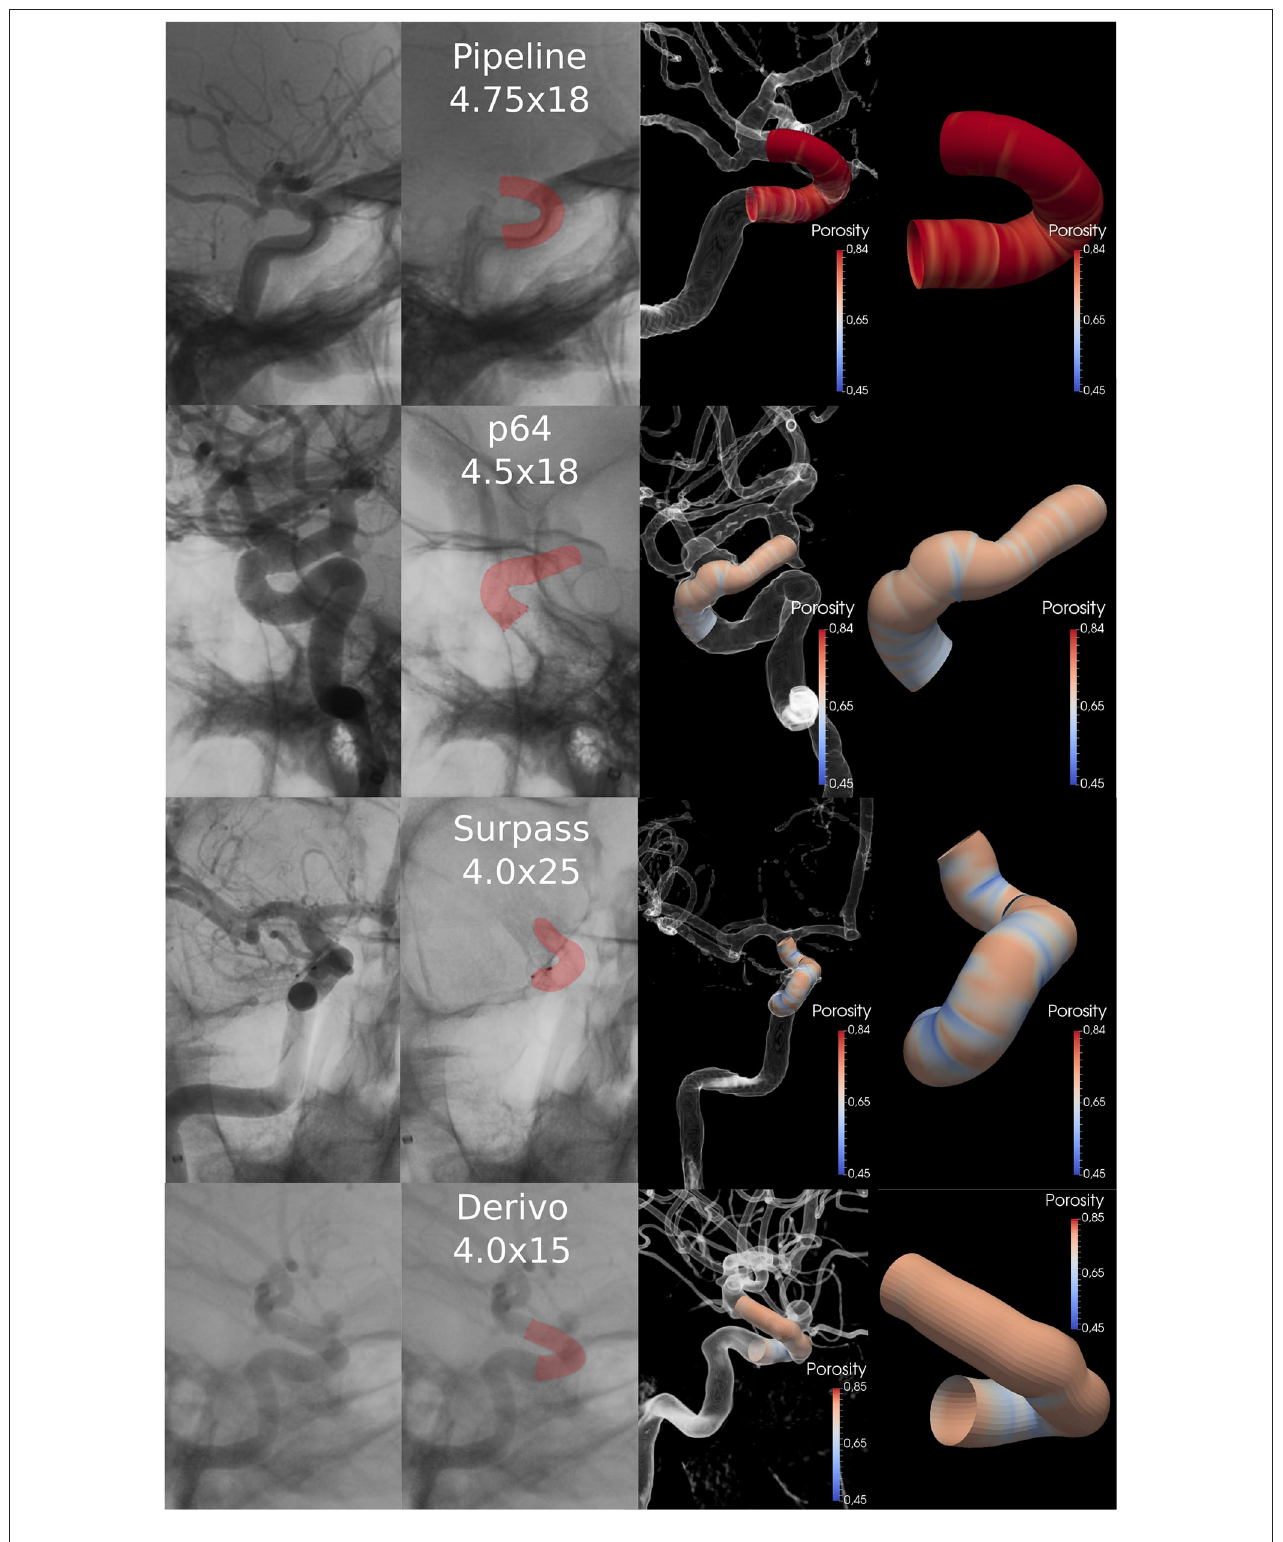
FIGURE 4 | Box-plot of the porosity for each FD, grouped by FD brand. FD, Flow-Diverter.